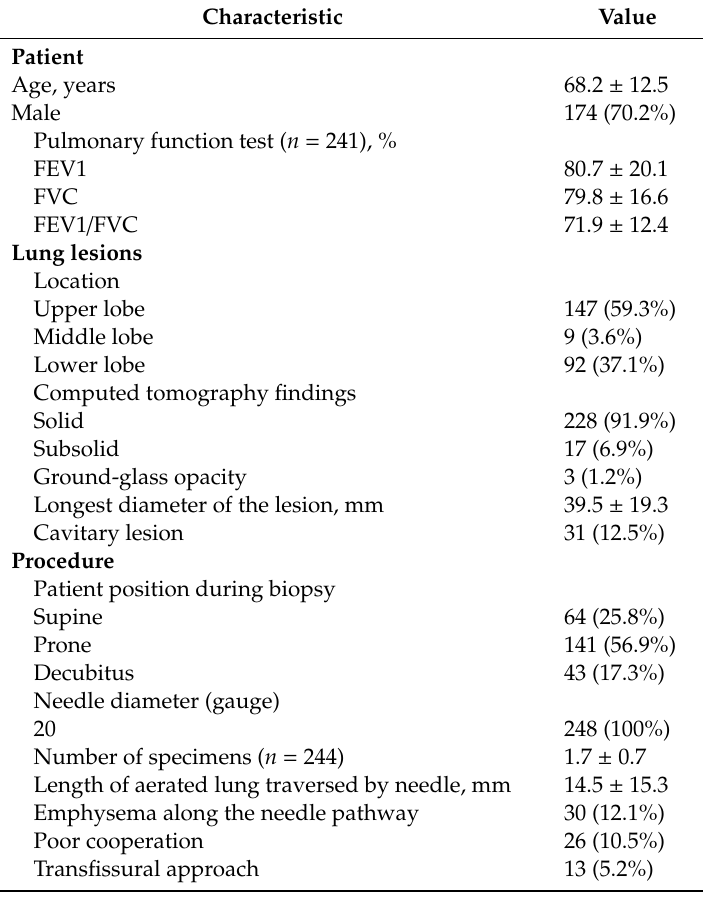
Table 1. Characteristics of patients undergoing computed tomography (CT)-guided percutaneous transthoracic needle biopsy (PTNB) ( n =